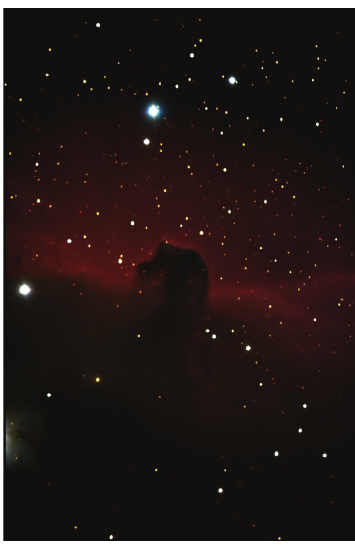
Figure 8: IC 434 and M42 images obtained by using the T35 telescope.